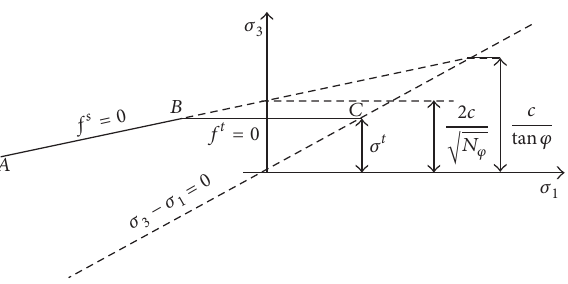
Figure 2: Composite Mohr–Coulomb failure criterion.